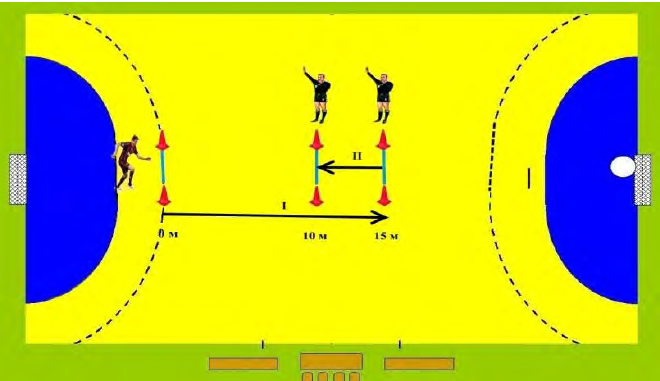
Fig.3. Schema of test №3